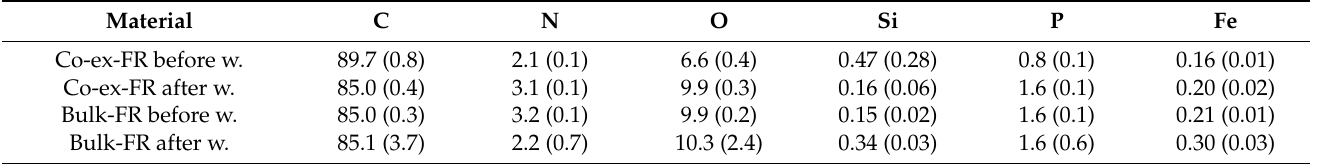
Table 15. Results of elemental analysis in atomic-% for profiles with FR CROS 490 before and after 28 days artificial weathering. Co-ex: co-extruded profiles; bulk: solid profiles (uncapped). Standard deviation in parentheses. Material C N O Si P Fe Co-ex-FR before w. 0.16 (0.01) Co-ex-FR after w. Bulk-FR before w. Bulk-FR after